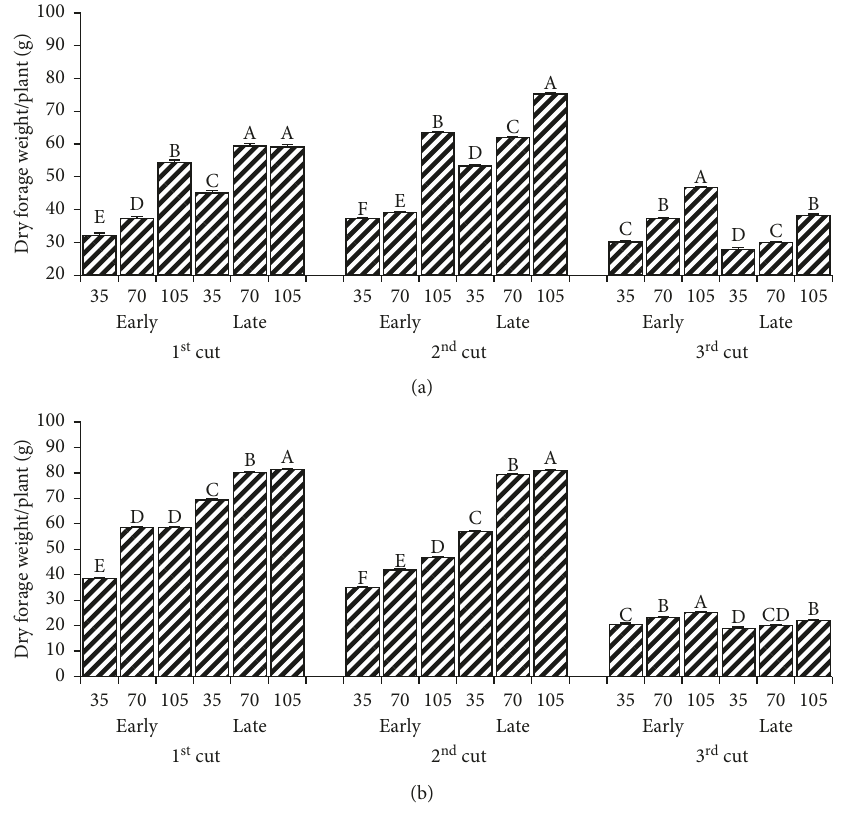
Figure 3: Dry forage weight/plant of Sudan grass as affected by the interaction between cutting date and nitrogen fertilizer levels at the three cuts in the first season (a) and the second season (b). The bars on the top of column represent the SE for each